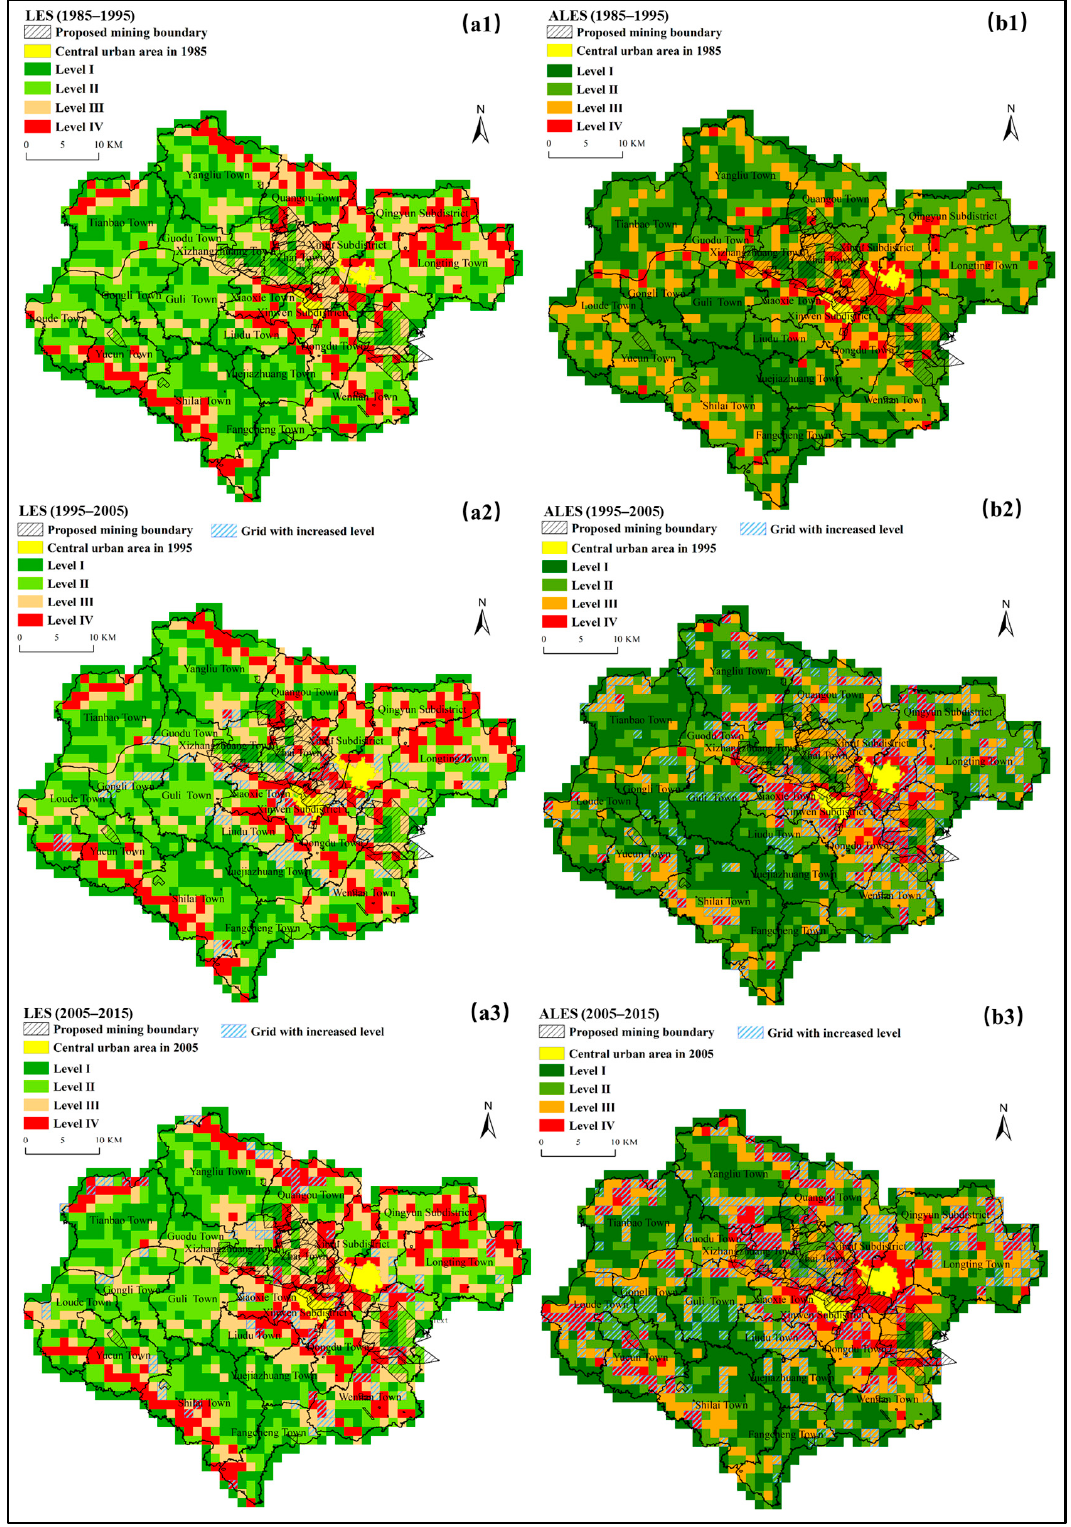
Figure 8. Temporal–spatial distribution of cultivated land LES and ALES. ( a1 ) landscape ecological security (LES) in 1985–1995. ( a2 ) landscape ecological security (LES) in 1995–2005. ( a3 ) landscape eco- logical security (LES) in 2005–2015. ( b1 ) adjusted landscape ecological security (ALES) in 1985–1995. ( b2 ) adjusted landscape ecological security (ALES) in 1995–2005. ( b3 ) adjusted landscape ecological security (ALES) in